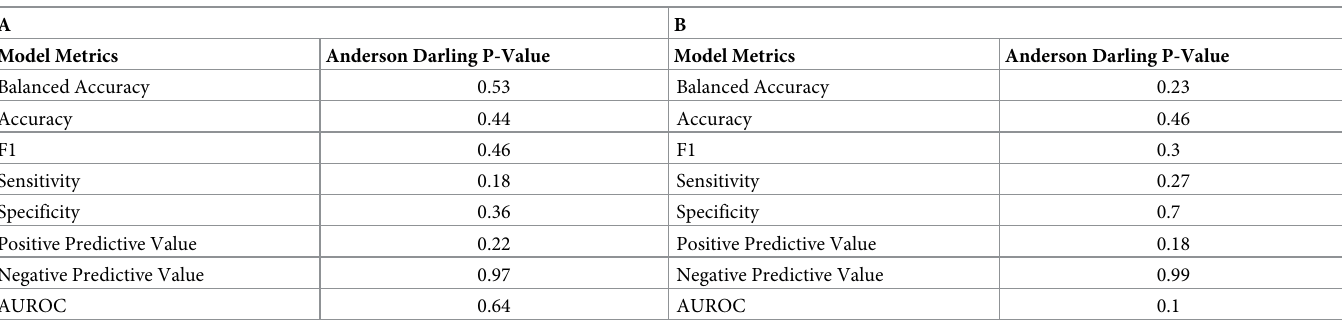
Table 4. XGBoost model summaries of anderson darling